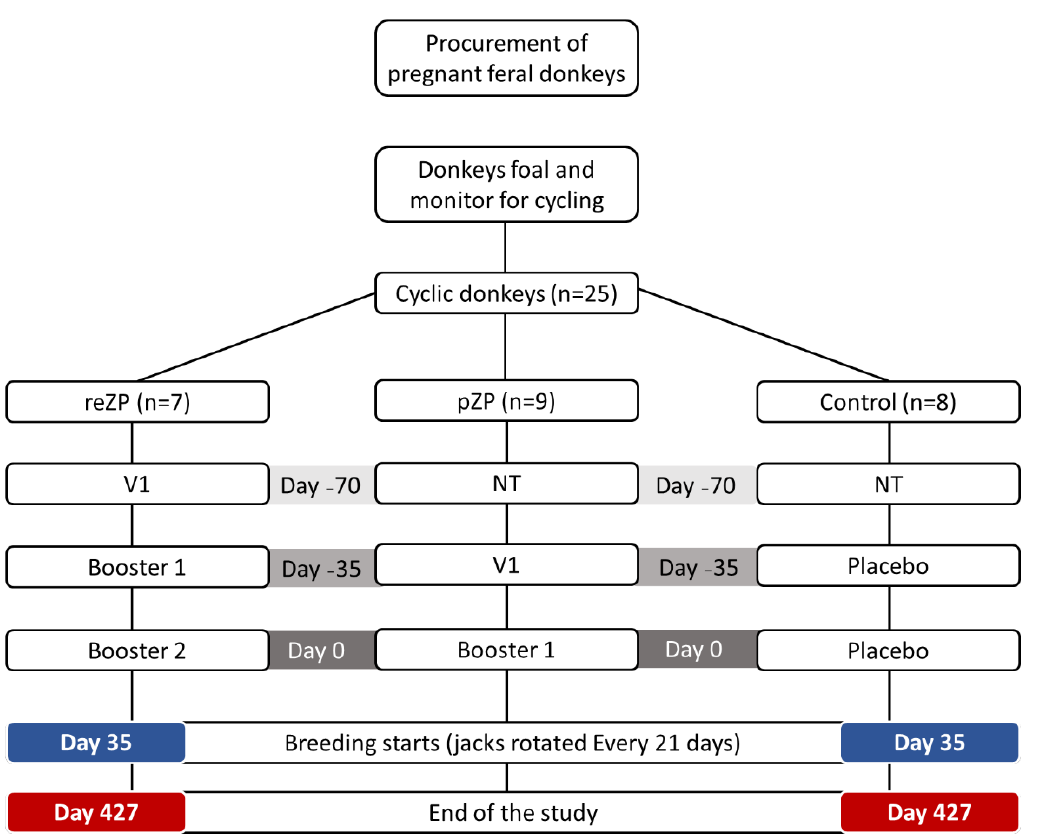
Figure 1. Timeline and treatment protocol for the 24 jennies treated with recombinant zona pellucida vaccine (reZP), porcine zona pellucida vaccine (pZP), or placebo (Control). NT, no treatment; V1, primary vaccination; Booster 1, 1st booster; Booster 2, 2nd booster. Day 0, day of the final vaccina- tion.